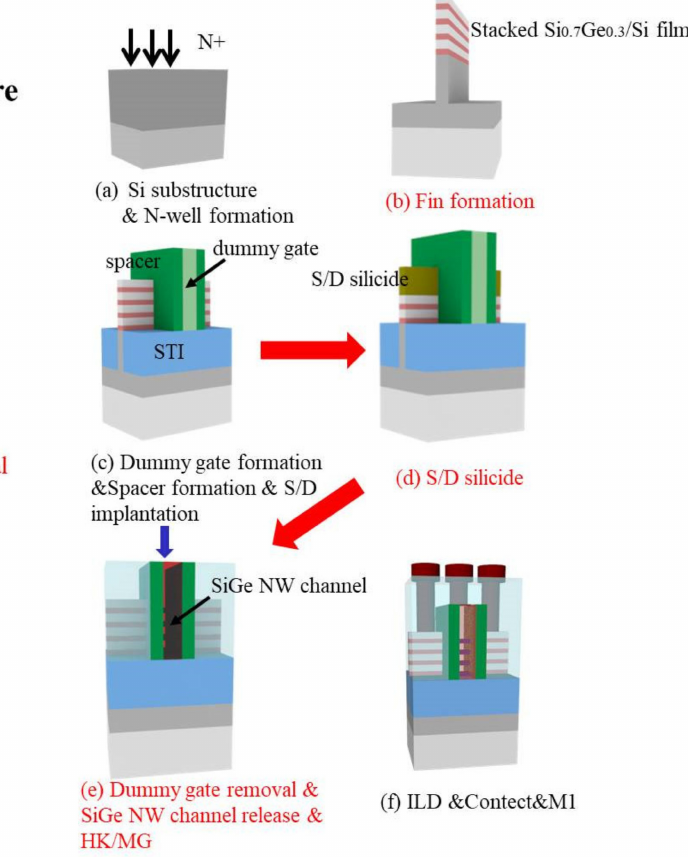
Figure 1. The process flow of stacked Si 0.7 Ge 0.3 NWs GAA p-MOS device. ( a ) Si substructure & N-well formation; ( b ) fin formation; ( c ) dummy gate formation & spacer formation & S/D im- plantaton; ( d ) S/D formation; ( e ) dummy gate removal & SiGe NW channel release & HK/MG; ( f ) ILD & Contect &